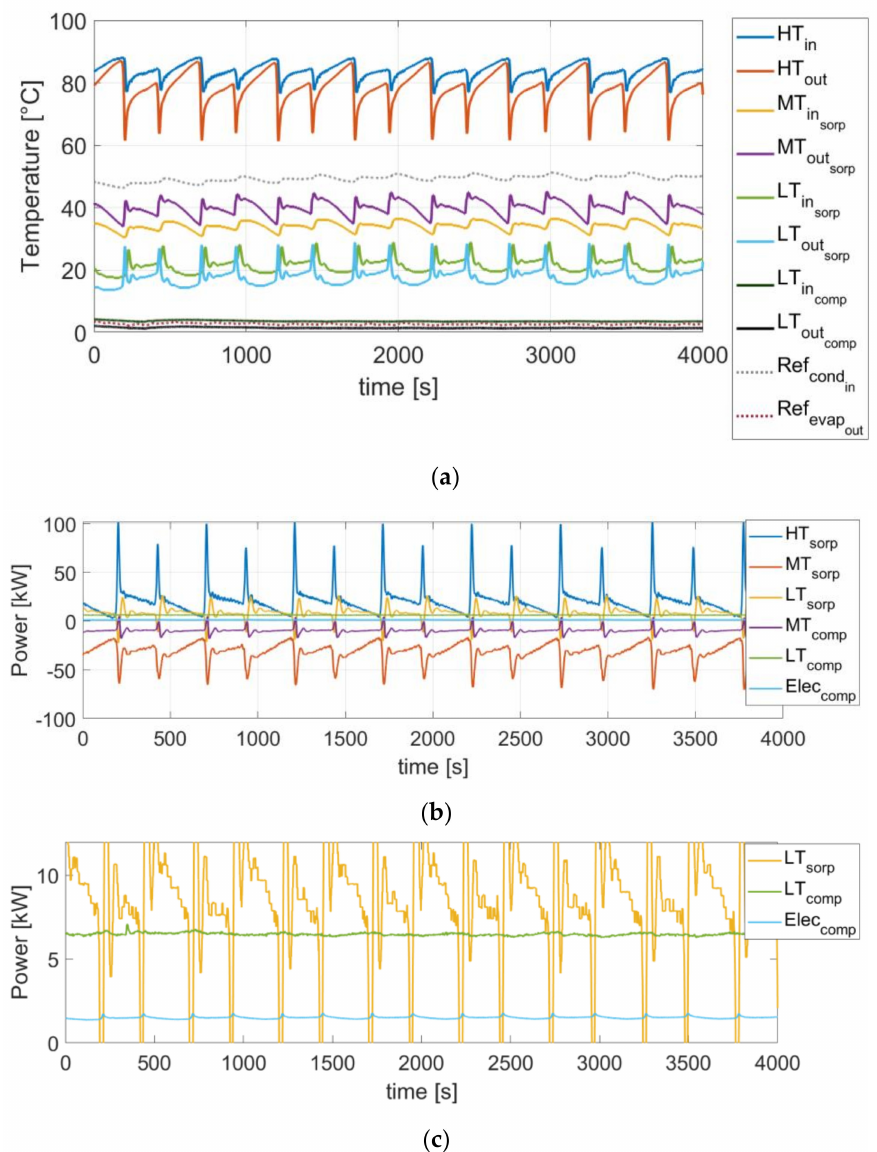
Figure 8. Example of test results for cooling mode 2. ( a ) Temperatures of HTF and R410a for sorption and compression units; ( b ) power measured in the HTF circuits and electricity consumption of the compressor; ( c ) detail of powers for the LT circuits of sorption and compression unit and electricity consumption of the